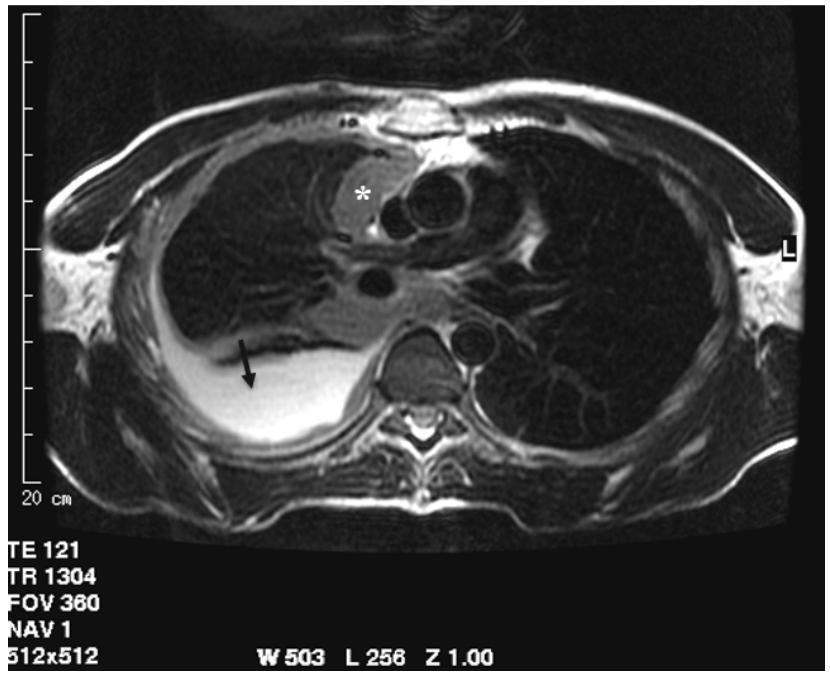
Figure 3. T2-weighted image acquired in the axial plane clearly demonstrates circumferential pleural thickening with mediastinal pleura involvement (asterisk) and pleural effusion